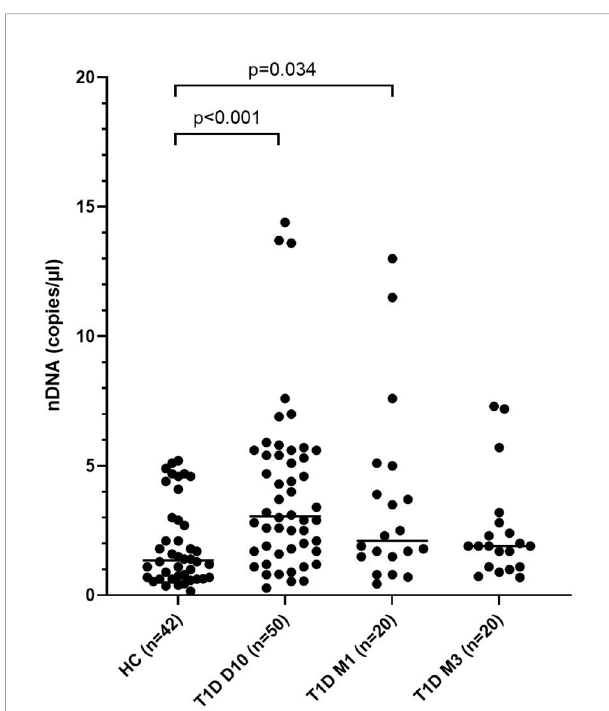
FIGURE 4 | Levels of nDNA in children with newly diagnosed type 1 diabetes (T1D) and healthy children (HC). Healthy children (n=42) were compared with children after onset of T1D; 10 days (n=50), 1 month (n=20) and 3 months (n=20) after onset (cohort 1, Mann-Whitney